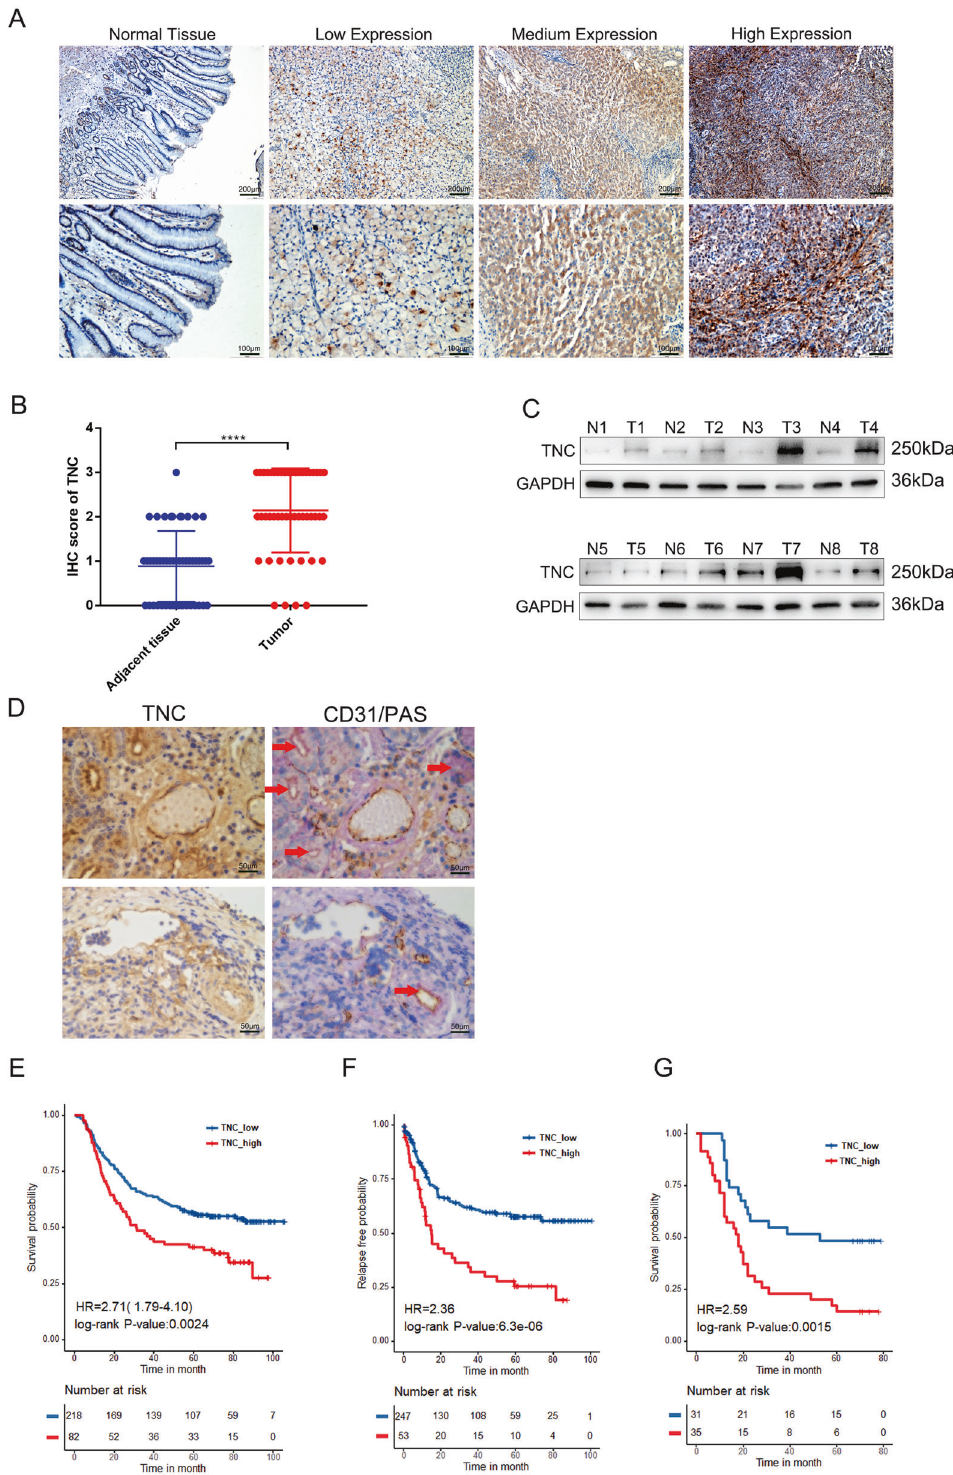
Fig. 1 TNC was upregulated in gastric cancer tissues and correlated with poor prognosis in gastric cancer patients. A A representative IHC staining of normal and tumor tissue (magni fi cation, ×100 and ×200). B TNC expression was signi fi cantly increased in gastric cancer tissues compared with adjust tissue. C Western blot analysis of TNC expression in gastric tissues and adjust tissue in eight patients. D IHC analysis of TNC, PAS and CD31 in gastric tissues; overall survival ( E ) and relapse-free survival ( F ) in patients with different TNC expression. Overall survival ( G ) of our single-center patients with different TNC expression. Results were shown as mean ± SD of three independent experiments; each experiment was performed in triplicate. **** P <